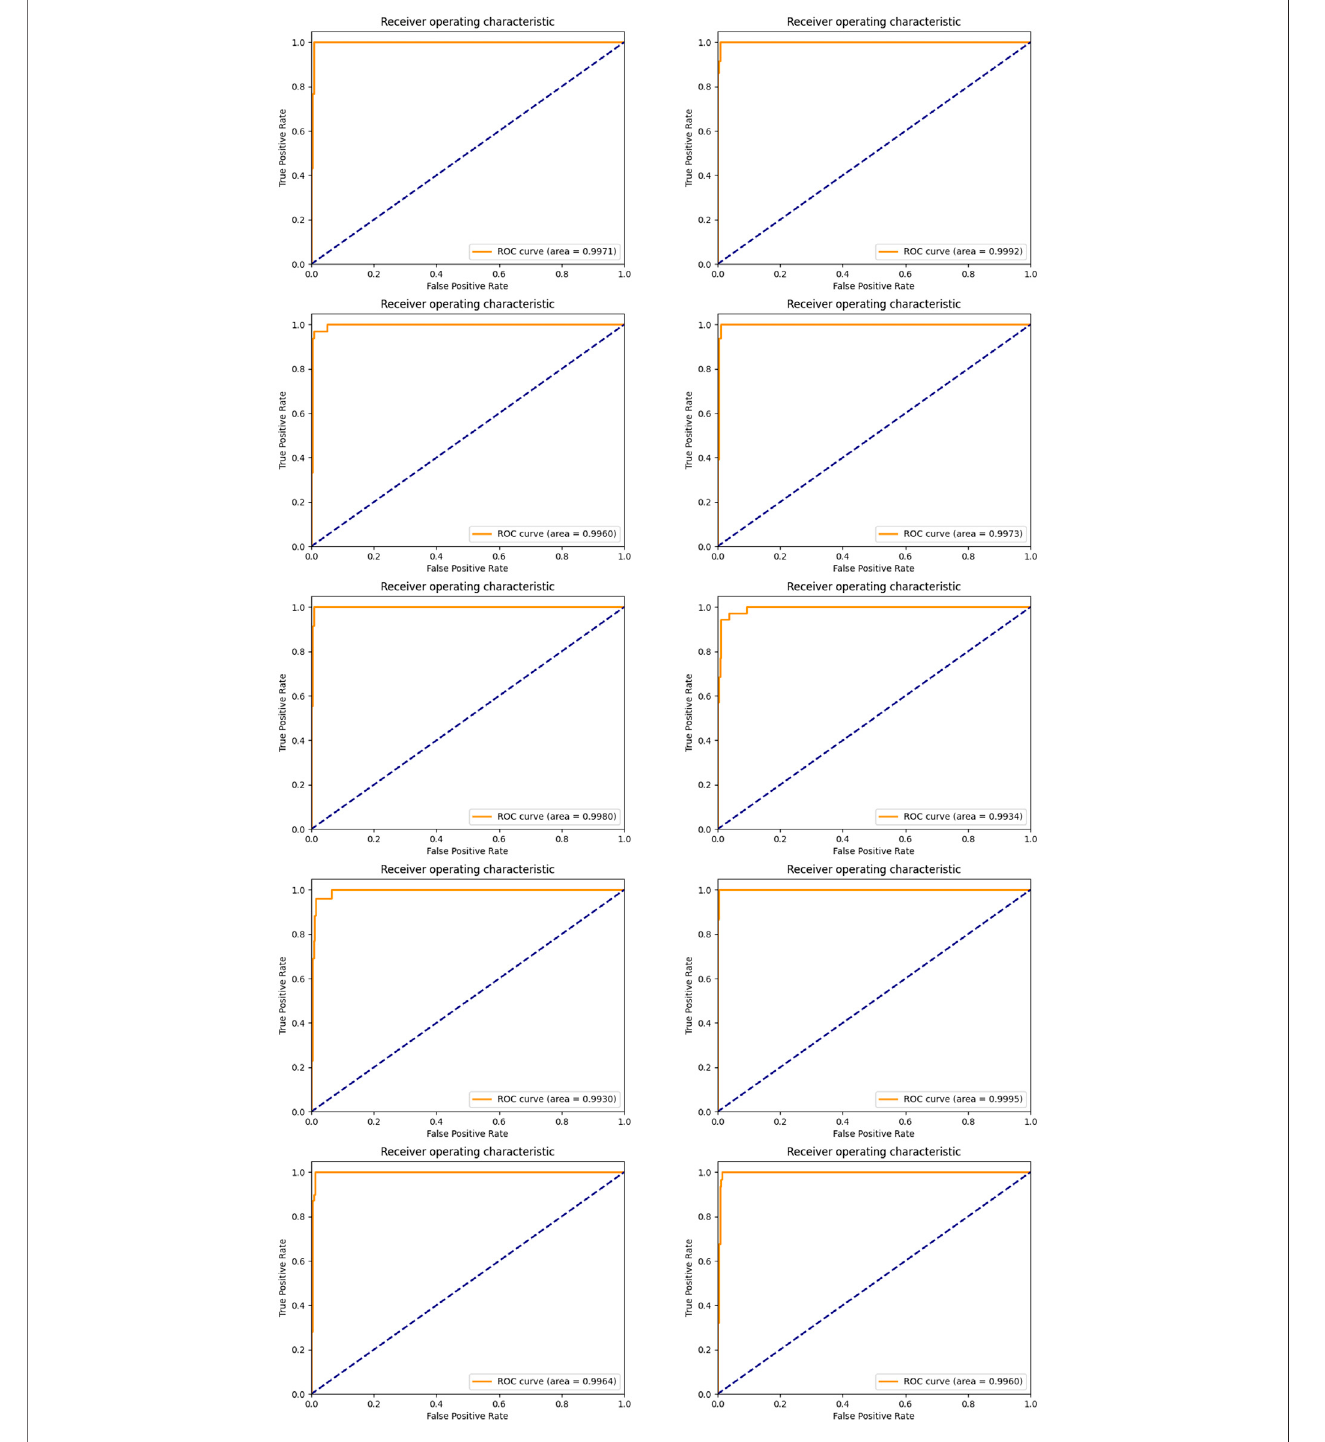
FIGURE 3 | ROC curves and the corresponding AUCs of selected miRNA candidates after ten-time sample division.